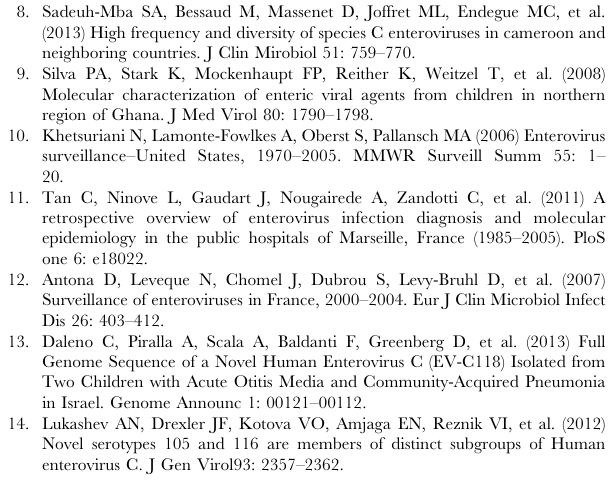
Figure S1 Comparative analysis of the full-length VP1 sequences of SV6, EV-J103, EV-J108, and the newly sequenced EV-J121 types. The similarity plots were generated using SimPlot version 3.5.1 with 100 nucleotide (nt) windows, 20 nt increments, and the Kimura 2-parameter method with a transition-transversion ratio of 8.0. Partial VP1 based trees depicting the relationships between the strains considered are presented at the bottom of the corresponding target portion. Table S1 Summary of the detection and sequencing in the 5 9 UTR, VP1 and 3D pol regions of enteroviruses among wild and captive non-human